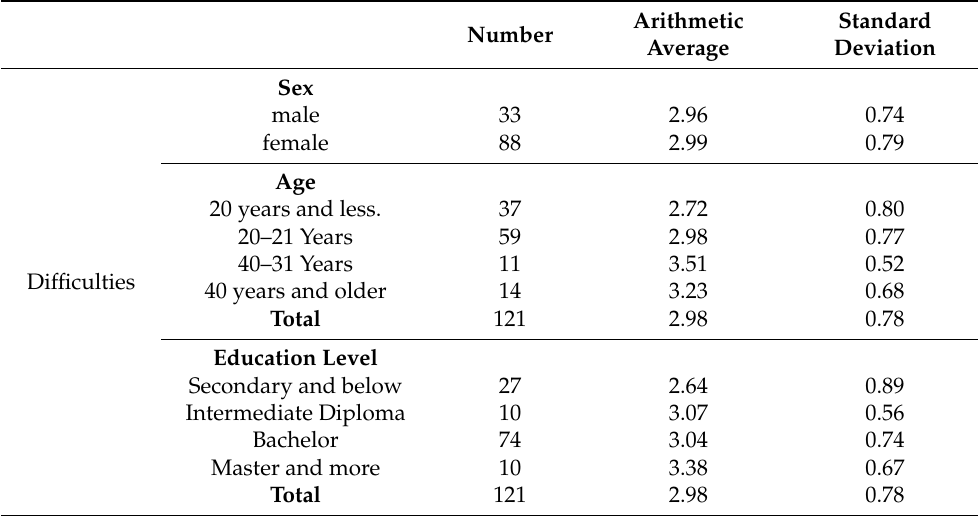
Table 7. The arithmetic averages and standard deviations used to determine the amount of difficulty participants confront as a result of changes in gender, age, and educational level.